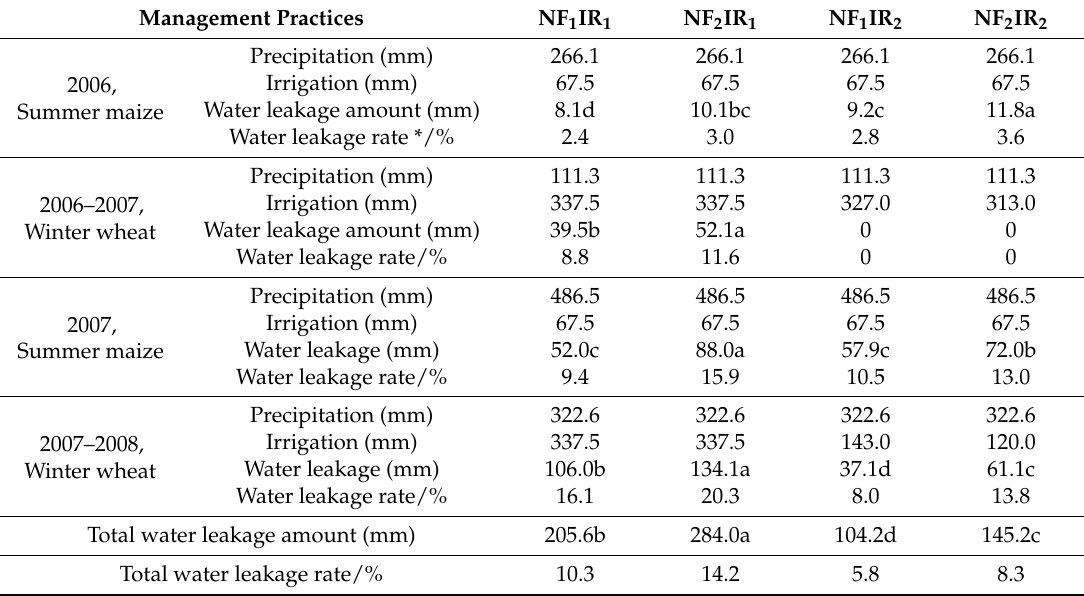
Figure 4. Monthly precipitation from June 2005 to May 2008 in Huantai County. Table 2. Soil water balance under different irrigation and fertilizer management practices.